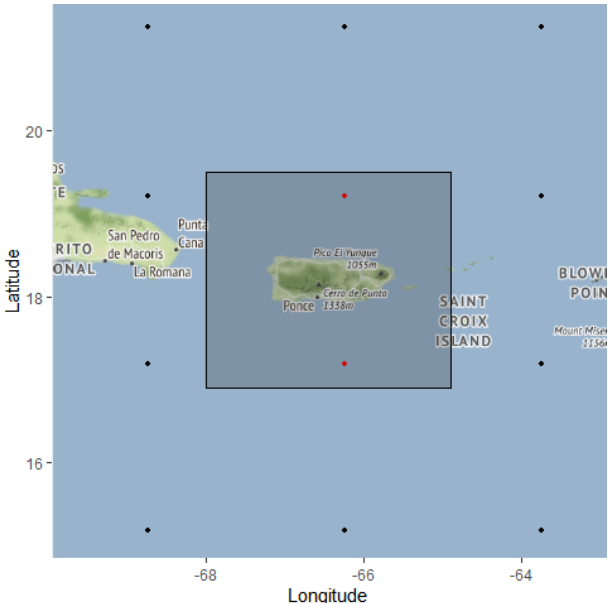
Figure A1. The bounding box for which GCM coordinates are kept (latitudes range from 16.90 to 19.50 ◦ , and longitudes range from − 68.00 to − 64.90 ◦ ). ESM2G locations inside the box (red) are kept, while ESM2G locations outside the box (black) are not kept. Note that the bounding box was only extended for this model. This image was created using a combination of © Google Maps 2018, Kahle and Wickham (2013), and Wickham (2016).